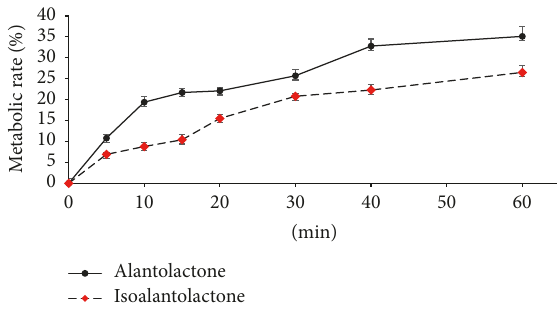
Figure 2: Metabolism profiles of alantolactone and isoalantolactone incubated with rat liver microsomes. Data are presented as mean ± SD, 𝑛 = 3 . Metabolic ratio = ( P − P × 100%, P 0 𝑡 )/ P 0 0 : peak area of 0 min; P 𝑡 , peak area of